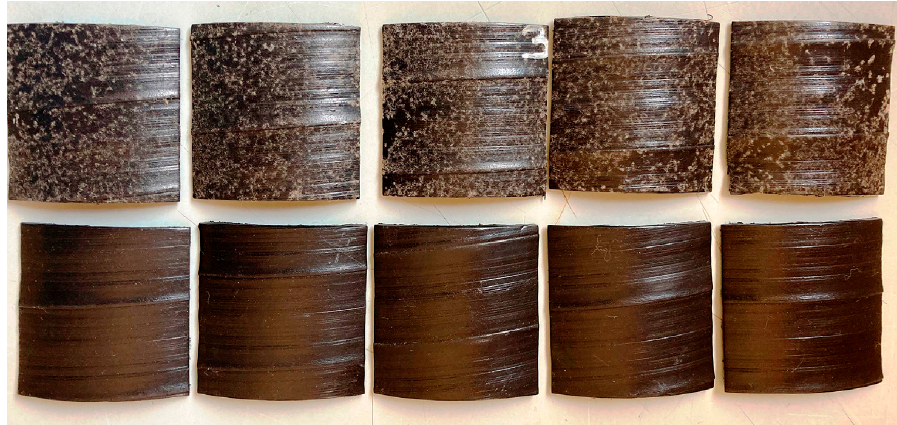
Figure 1. Testing of the fungal resistance of paint and varnish coatings (bottom row-control). After 28 days of testing (temperature 30 °C, relative humidity more than 90%) on the surface of the material the growth of test-cultures in the form of a light-colored plaque, in particular Aspergillus terreus (VKM F-1025) is visible with the naked eye.